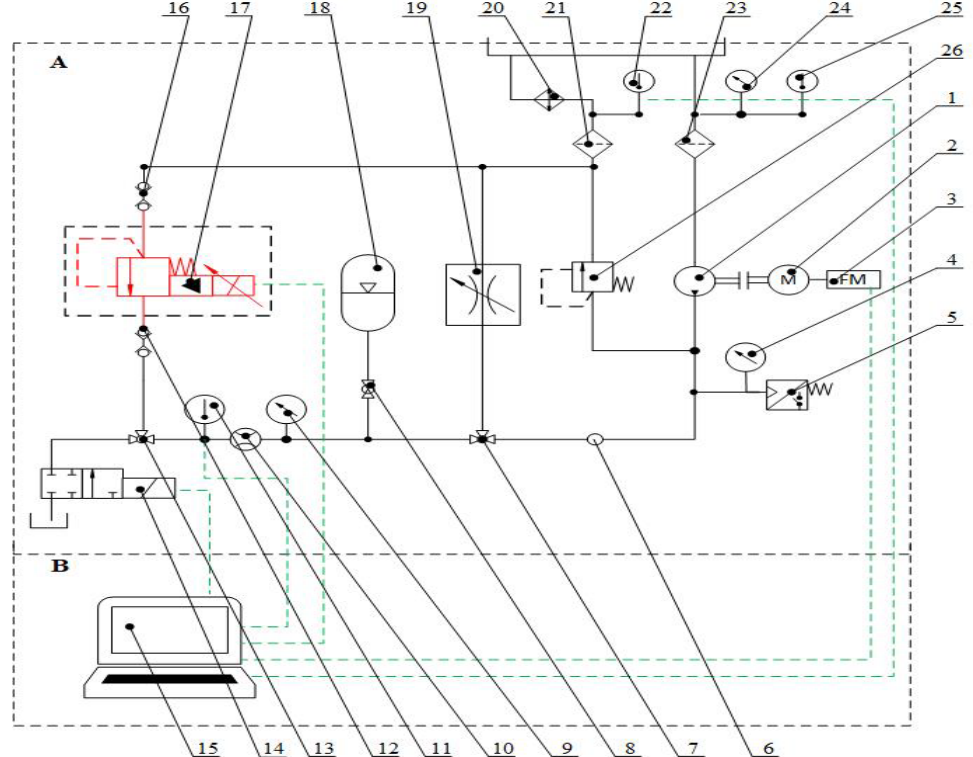
Figure 1. Scheme of hydraulic circuit for testing hydrostatic transducers and hydraulic fluid